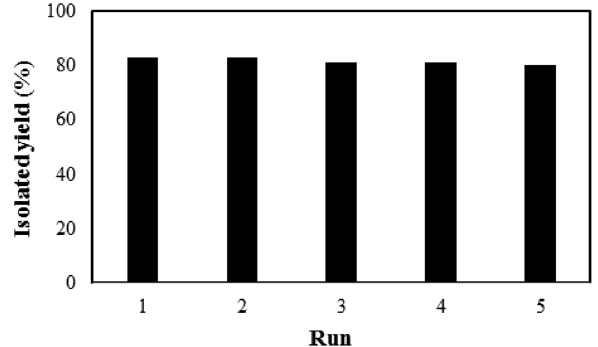
Figure 4. The recovery results of Pd@m FuVe